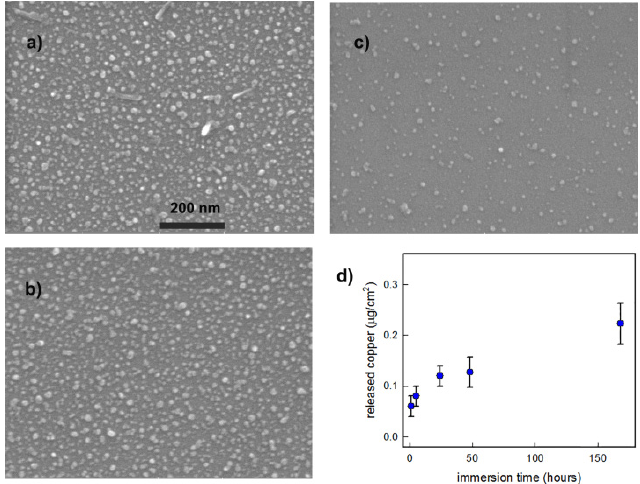
Figure 3. Behavior of CuS NP-glass samples upon immersion in water: ( a ) SEM image of a portion of a standard sample soon after preparation; ( b ) SEM image of a portion of the same sample after 24 h of immersion in water; ( c ) SEM image of a portion of the same sample after one week of immersion in water; ( d ) copper released from standard 21 × 26 mm samples in 5 mL of distilled water at different times (max: 1 week) expressed as micrograms released per cm 2 of surface(samples mean copper surface concentration: 0.5 (1) μ g/cm 2 ).